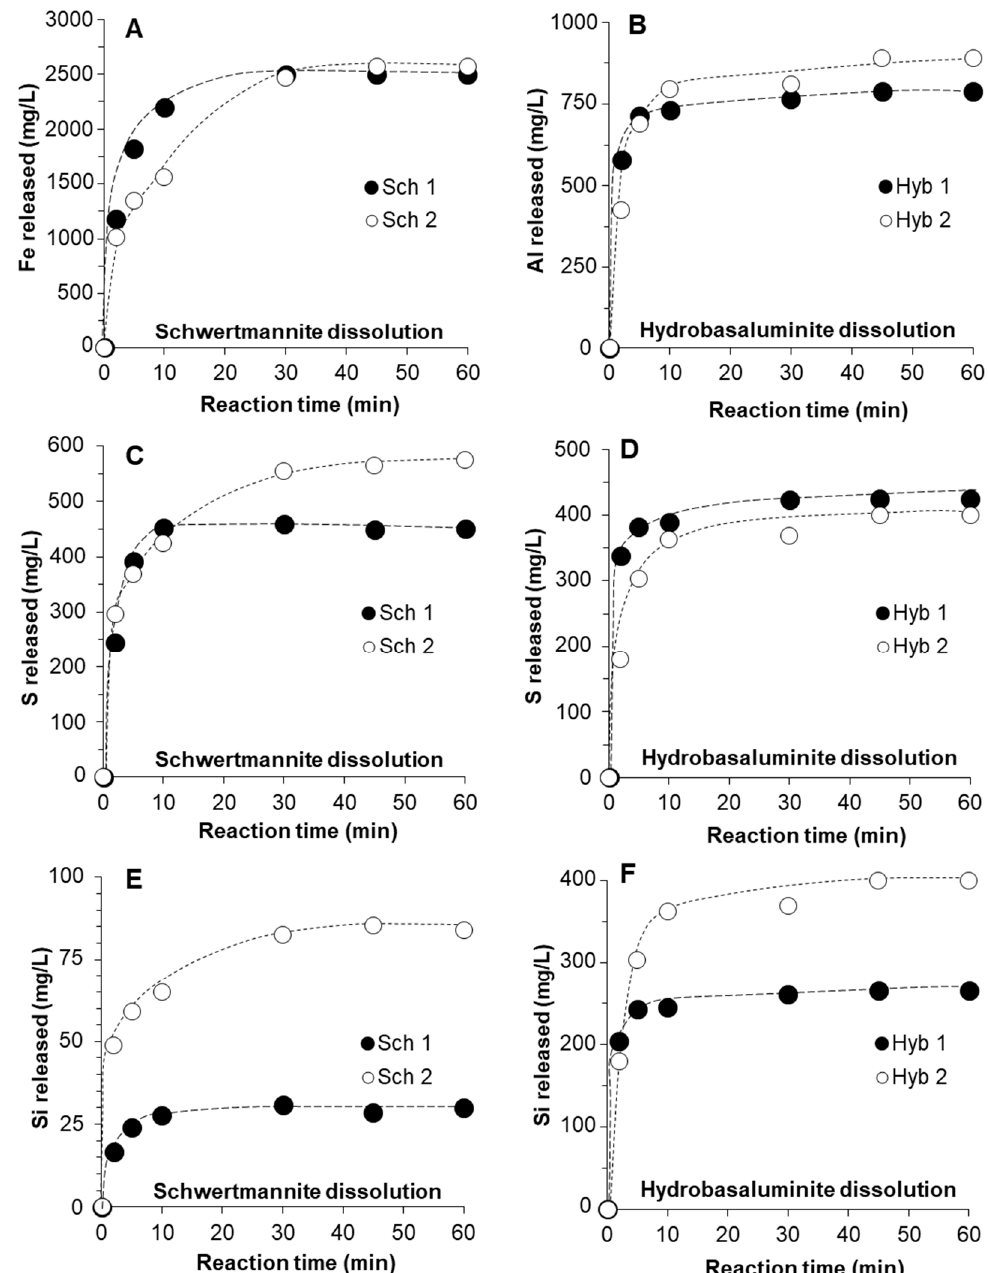
Figure 1. Progressive release of iron (Fe ( A )), aluminum (Al ( B )), sulfur (S ( C,D )), and silicon (Si ( E,F )) during dissolution of schwertmannite (left column) and hydrobasaluminite (right column) in ammonium oxalate solution at pH 3.0.